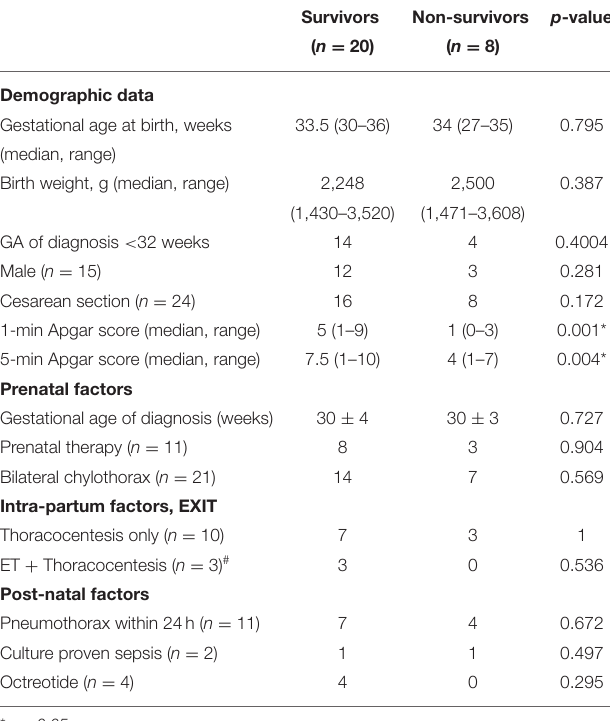
TABLE 3 | Demographics and clinical variables in surviving and non-surviving